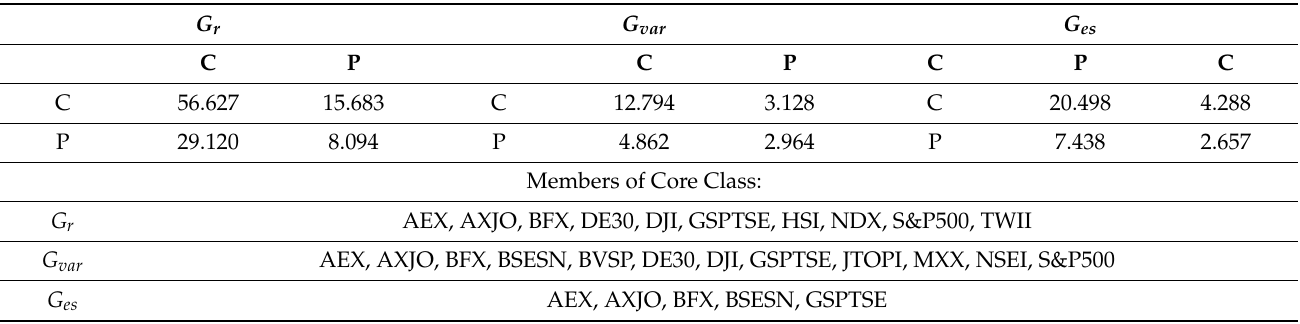
Table 2. Core-Peripheral Analysis Results: Density Matrix.